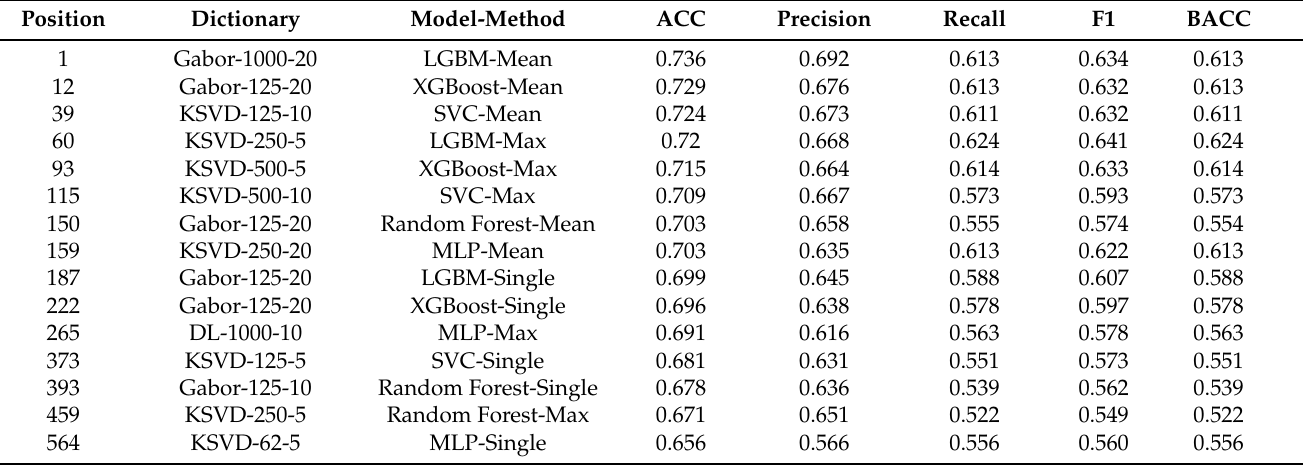
Table 2. Summary of average metrics scores for each aggregation method and classifier model, class size =